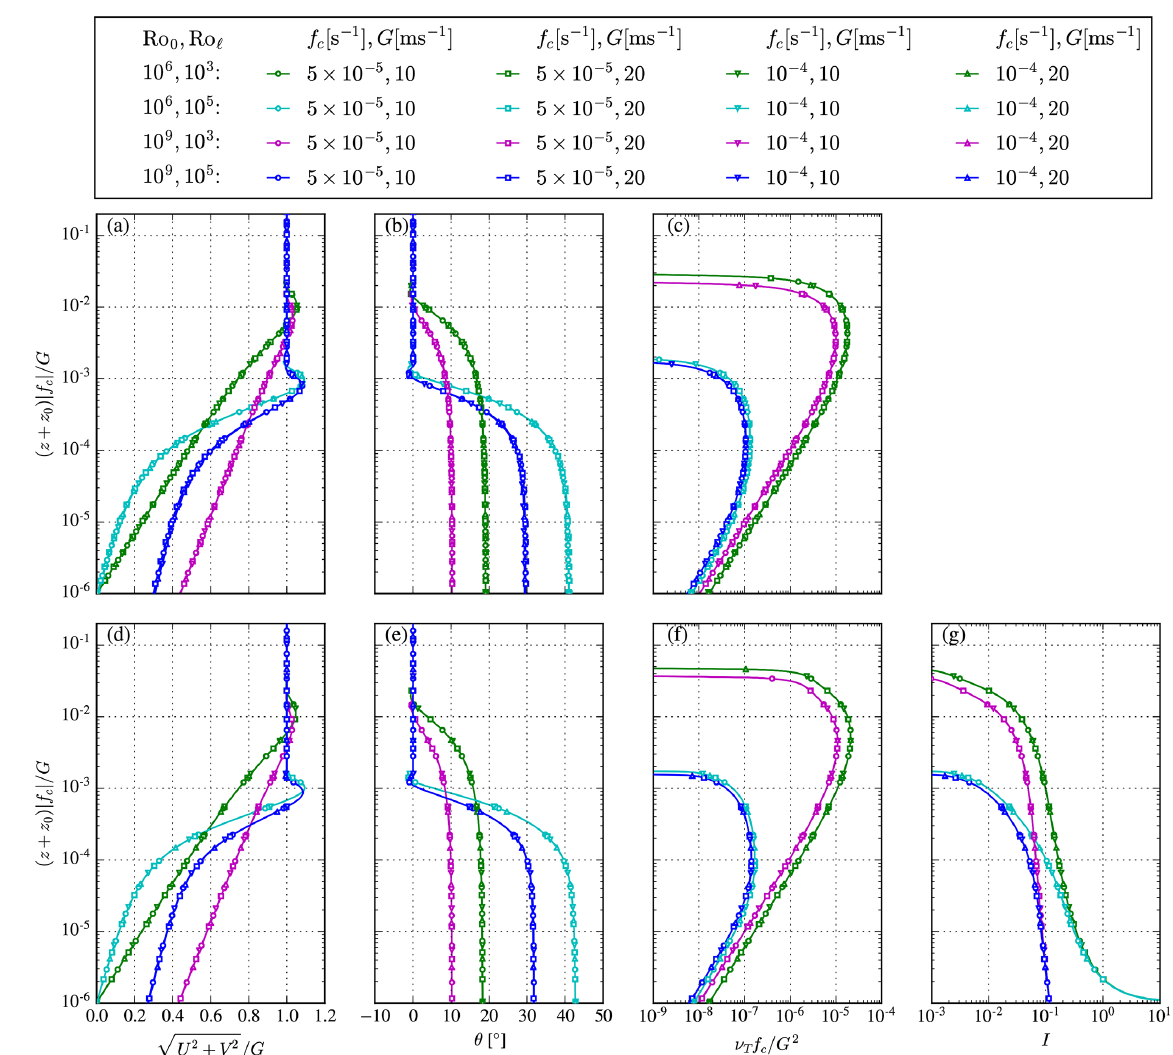
Figure 3. Rossby number similarity of the original turbulence closures. (a–c) Limited mixing-length model. (d–g) Limited-length-scale k – ε